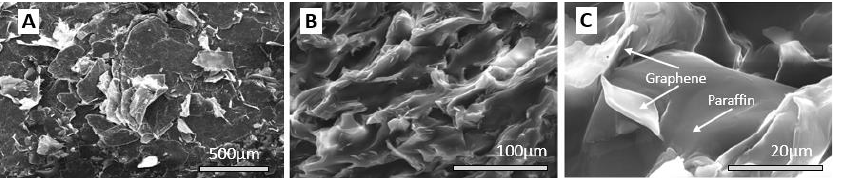
Figure 3. Microstructure of multilayer graphene ( A , B ) and 1% graphene – paraffin composite (PCM- 1G) ( C ). Images were taken on sample cross-sections obtained by fracture of solid samples after liquid nitrogen immersion and then coated with 3 nm platinum.